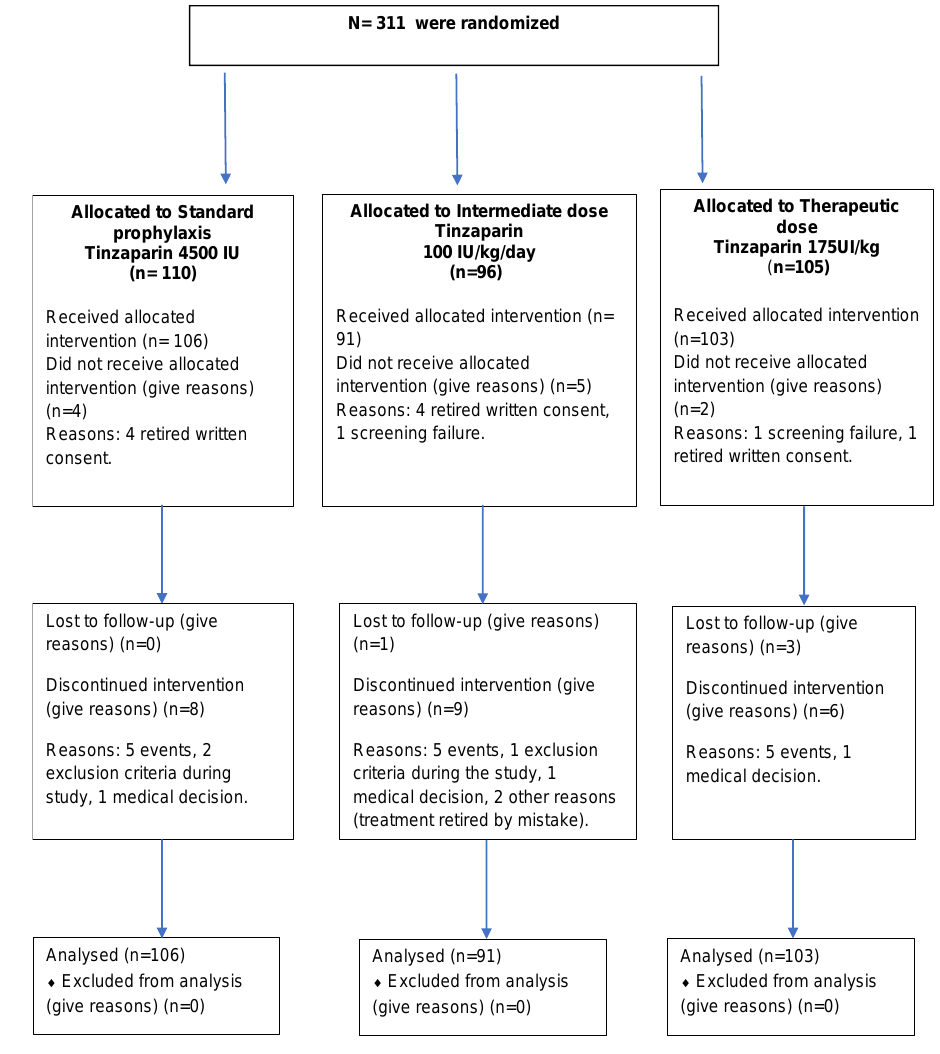
Figure 2. Flow chart for the PROTHROMCOVID trial.